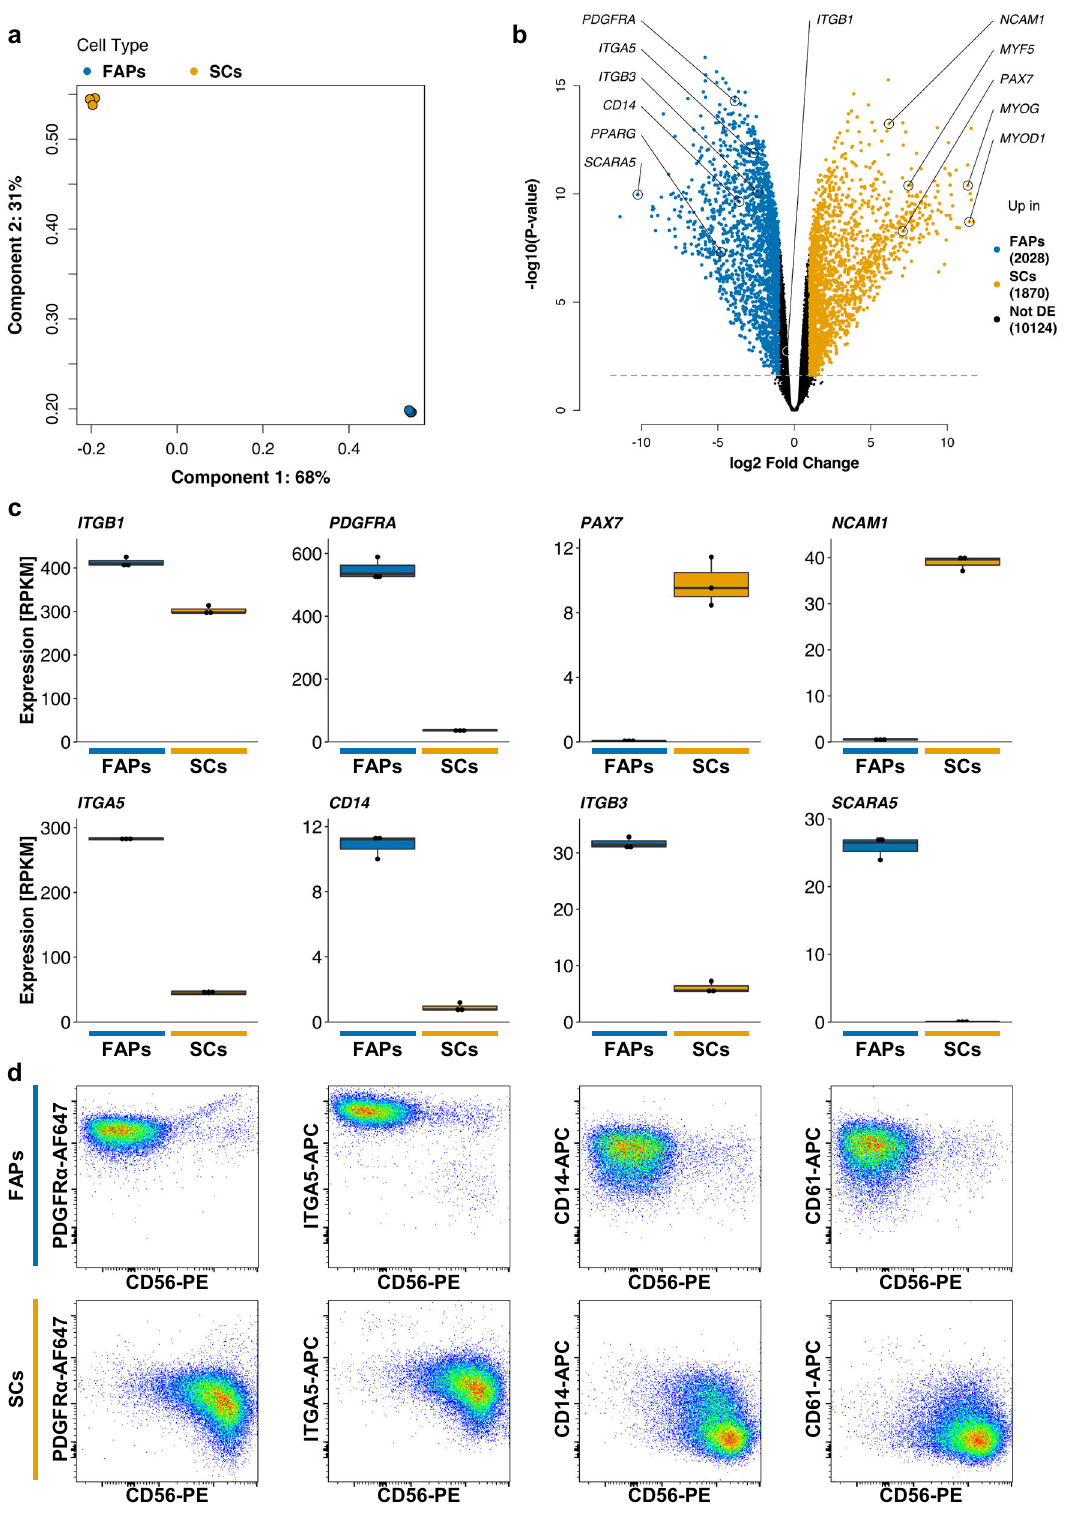
Fig. 2 Transcriptomic and immunophenotypic characterisation of FAPs. a Principal component analysis of gene expression pro fi les of FAPs (blue) and SCs (orange) as determined by RNA sequencing, based on the 500 most variably expressed genes ( n = 3 for each cell type). b Volcano plot showing differentially expressed genes between FAPs (blue) and SCs (orange), as determined by RNA sequencing ( n = 3). Genes corresponding to selected key FAP and SC markers are indicated. Dashed line indicates signi fi cance cutoff at a false discovery rate of 0.05. c Box plots showing the expression of selected key FAP (blue) and SC (orange boxes) marker genes ( n = 3), as determined by RNA sequencing. Results are expressed in terms of reads per kilobase million (RPKM). d Comparative fl ow cytometric analysis of FAPs and SCs, based on surface expression of PDGFR α -AF647, ITGA5-APC, CD14-APC, or CD61-APC, each combined with